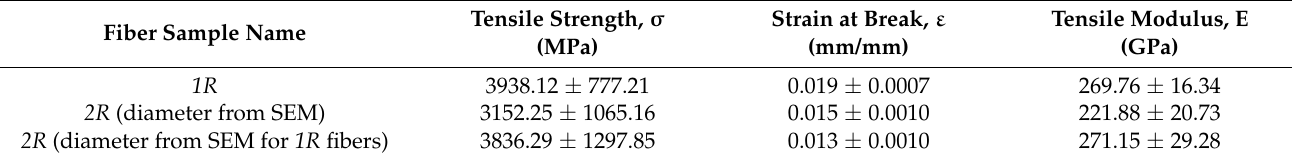
Table 4. Tensile properties of recycled carbon